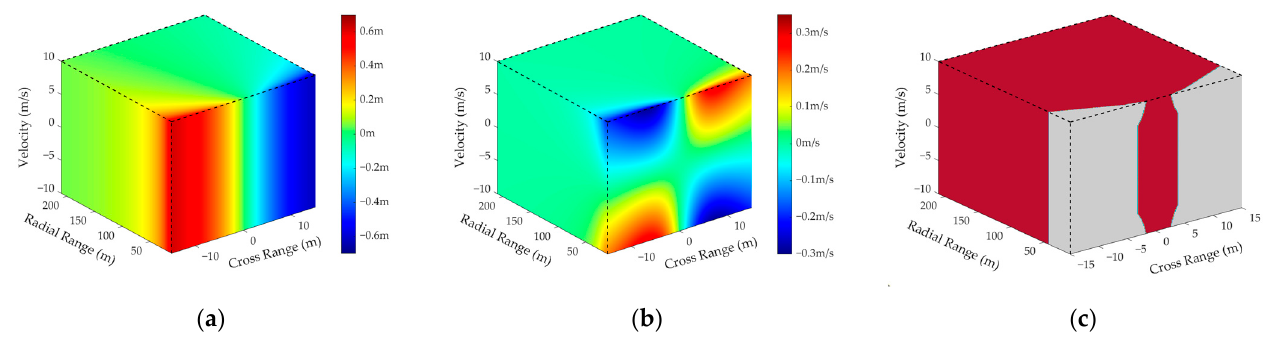
Figure 9. The simulation results of Test 4. ( a , b ) display the range and velocity deviations. ( c ) represents radar detection scenario, including effective region (red) and ineffective region (gray).